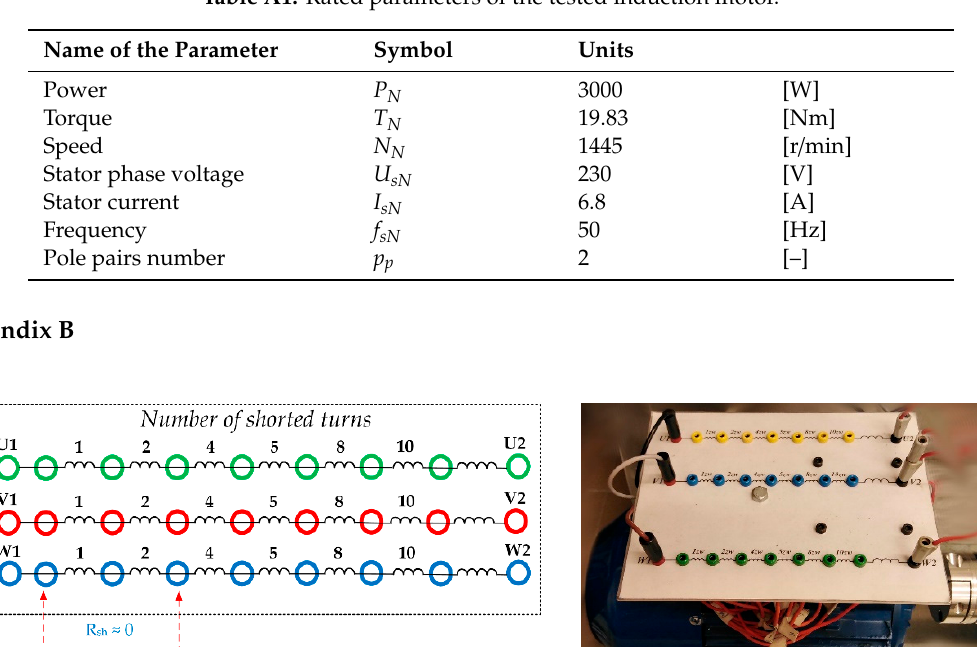
Table A1. Rated parameters of the tested induction motor.